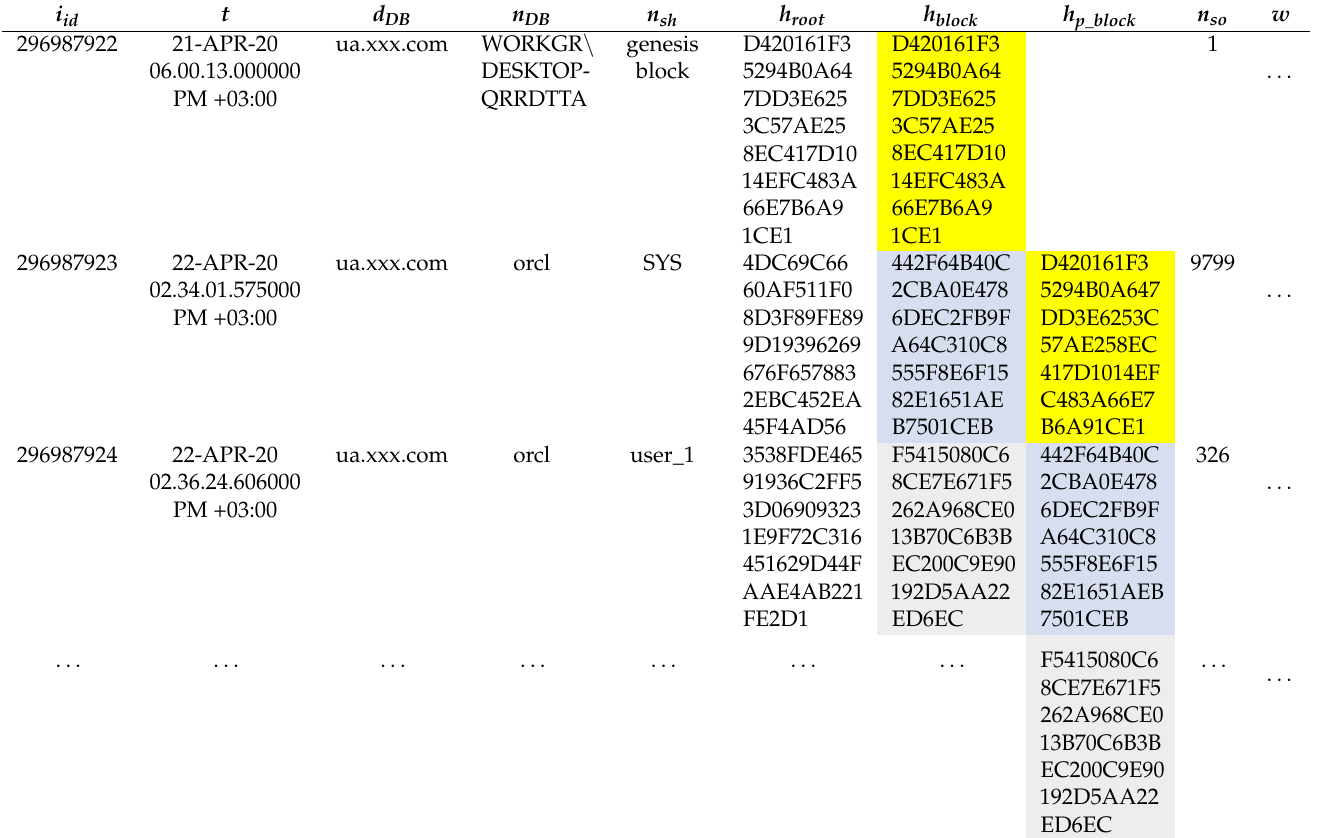
Table 1. An example of a partially filled table of blockchain block headers. *